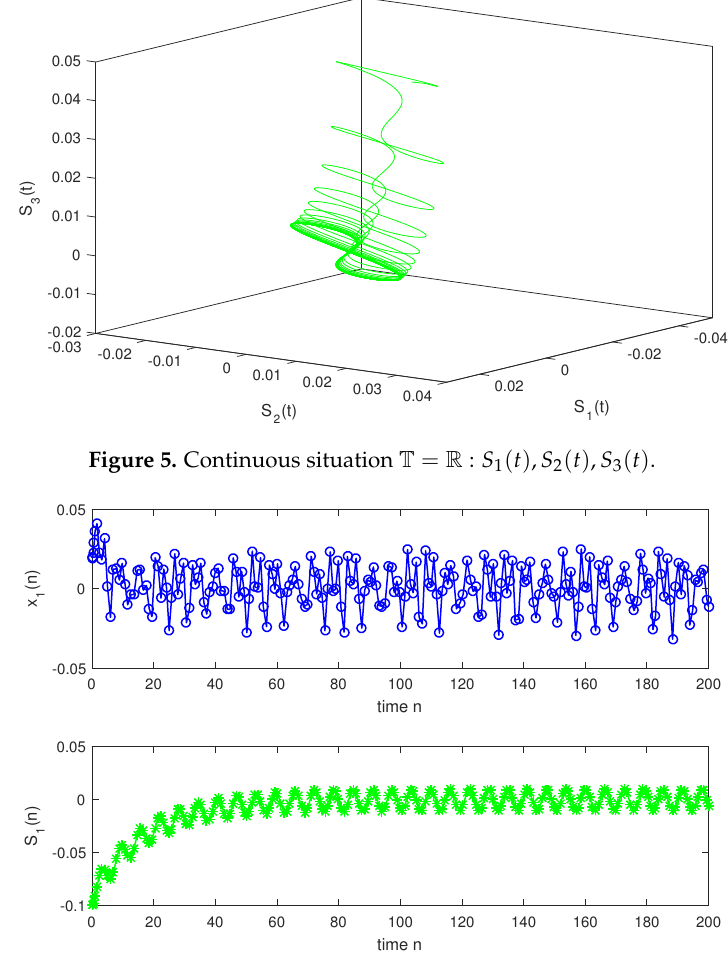
Figure 6. Discrete situation T = Z : x 1 , S 1 with n